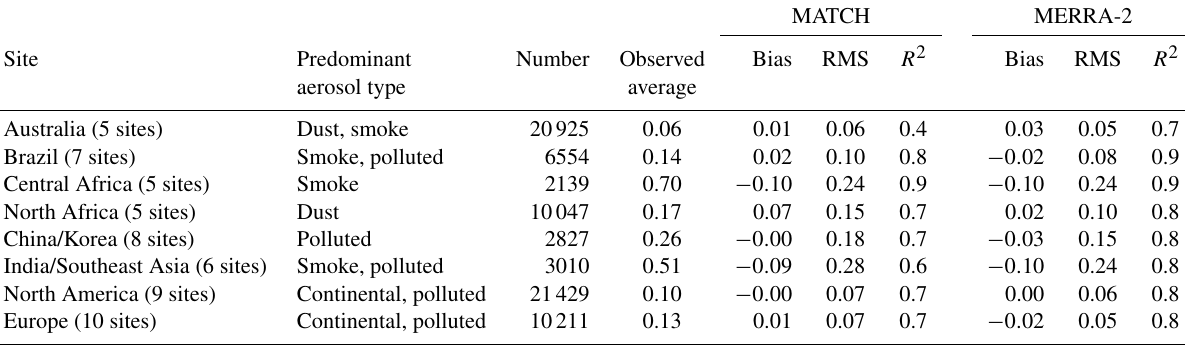
Table 3. Hourly AERONET station statistics for MATCH and MERRA-2 for continental groups under clear-sky conditions ∗ .